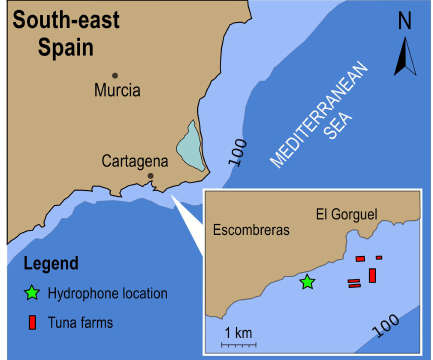
Figure 7. Cartagena region, showing the tuna farm and the UNDEX sites (red squares) as well as the hydrophone location (green star). The distance from the UNDEX to the hydrophone was approximately 1.2 km.